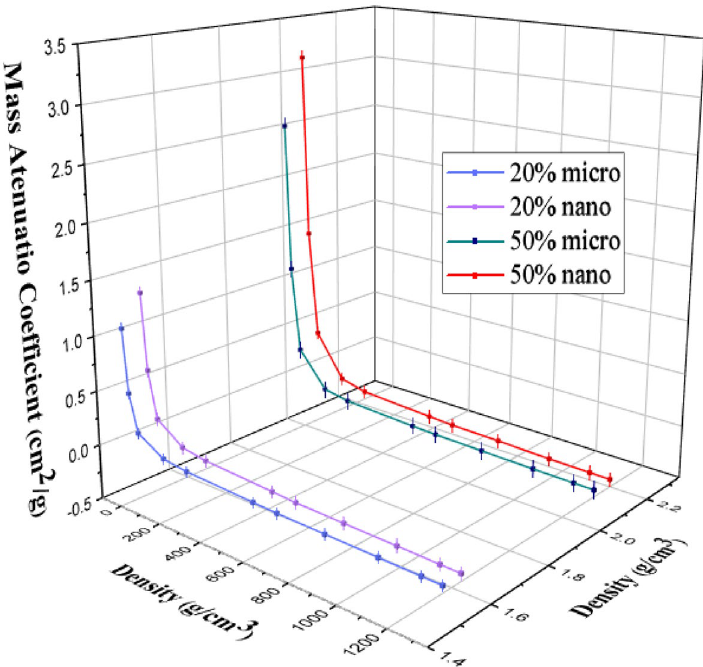
Figure 8. The relationship between the densities of nano- and micro-SnO 2 /SR and their MAC at different energy.